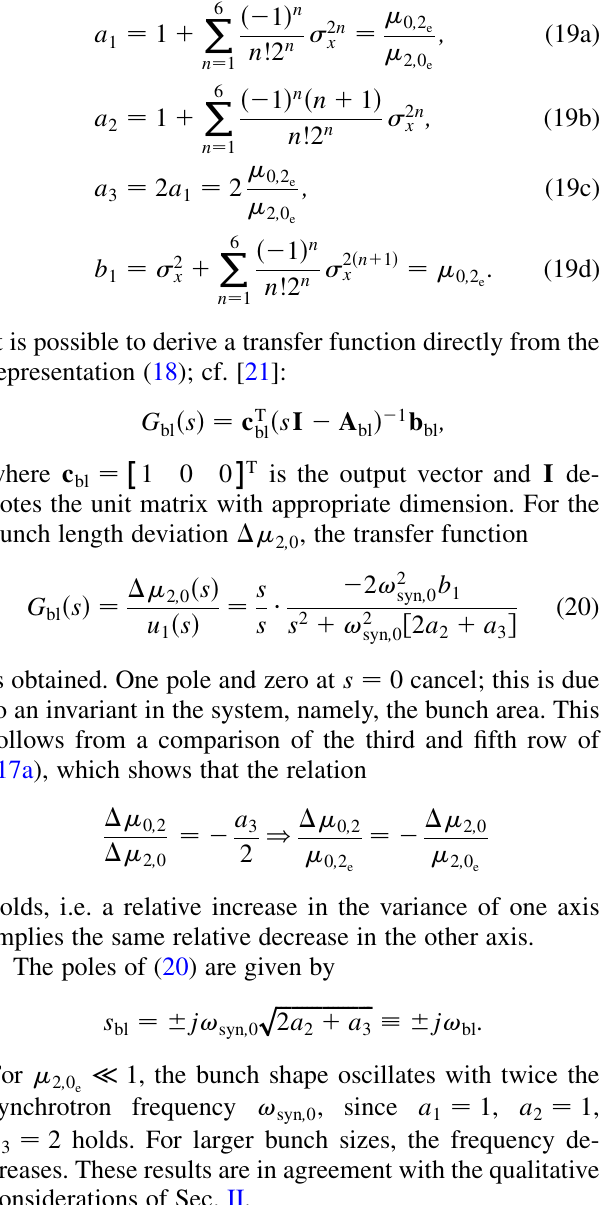
FIG. 3. Oscillation frequencies of the bunch shape: coherent frequencies [black line; cf. (21)], effective frequency [blue line; cf. (22)], and nonlinear tracking simulations ( (cid:4)